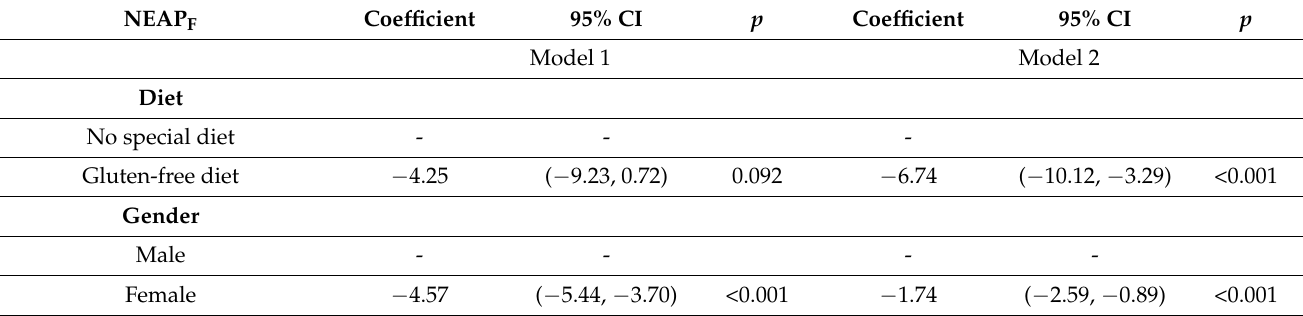
Table 6. Weighted linear regression estimates of predictor variables for outcome variable (NEAPF): model 1 (left columns) and model 2 (right